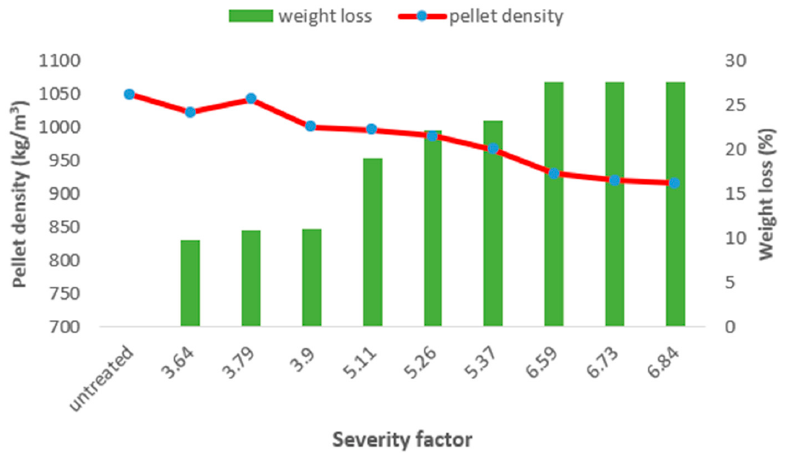
Figure 7. Pellet unit density and weight loss of raw WSS and WSS biochar for different severity factors.